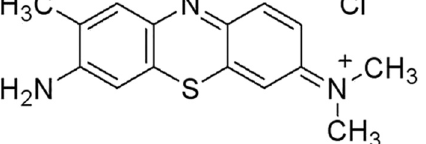
Figure 3: Mouse uteri of early pregnancy on day 4 stained with TB ( a ) and XP ( b ) . 1 = perimetrium, 2 = myometrium, and 3 = endometrium. 100 × fi nal magni fi cation. Bar = 60